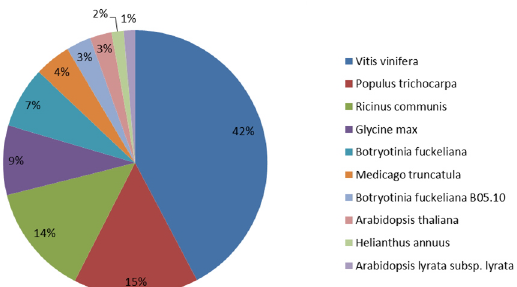
Fig 3. The percentage of the chrysanthemum unigenes that showing similarity to genes in other plant species. The chrysanthemum unigenes aligned by BLASTx to the Nr database.